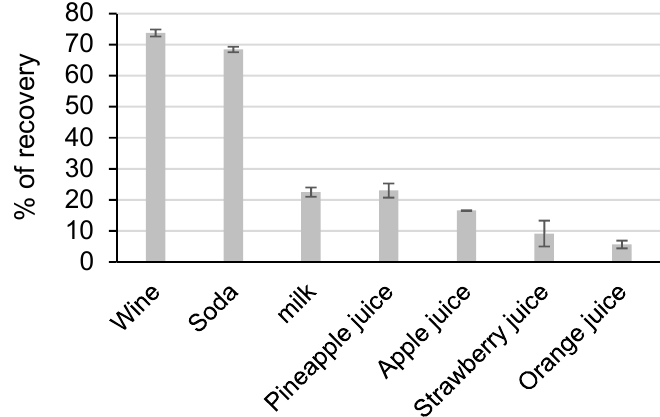
Figure 6. Percentage of DNA recovery from different beverage matrices. Standard deviation was calculated from four independent experiments.